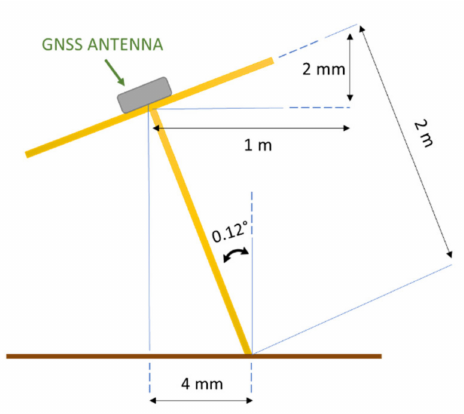
Figure 7. Positioning inaccuracy of the geolocation device due to bubble